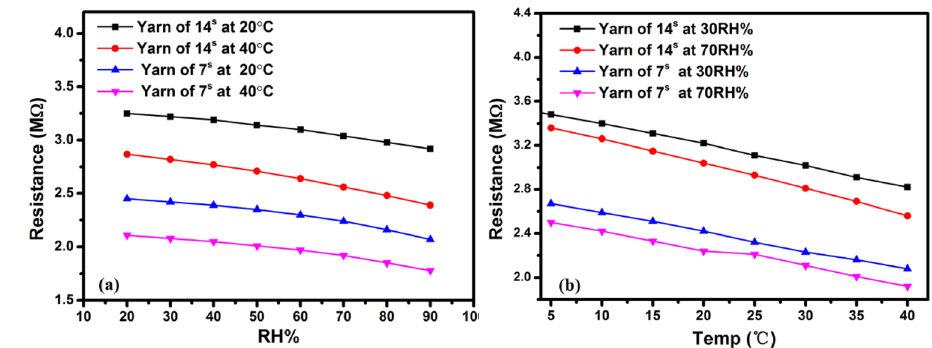
Fig. 7 Influence of tempera- ture and humidity on yarn resistance: a cotton yarn resist- ance under different humidity,